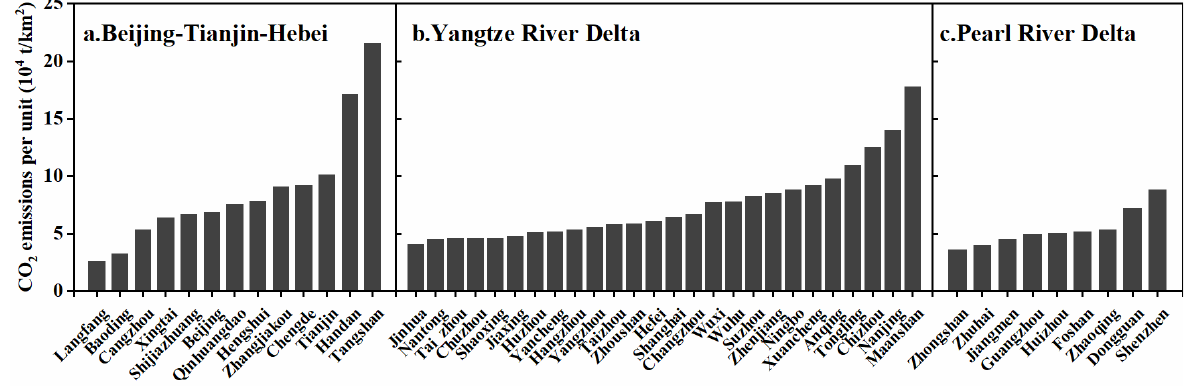
Figure 6. CO 2 emissions per unit in cities of three urban agglomerations.